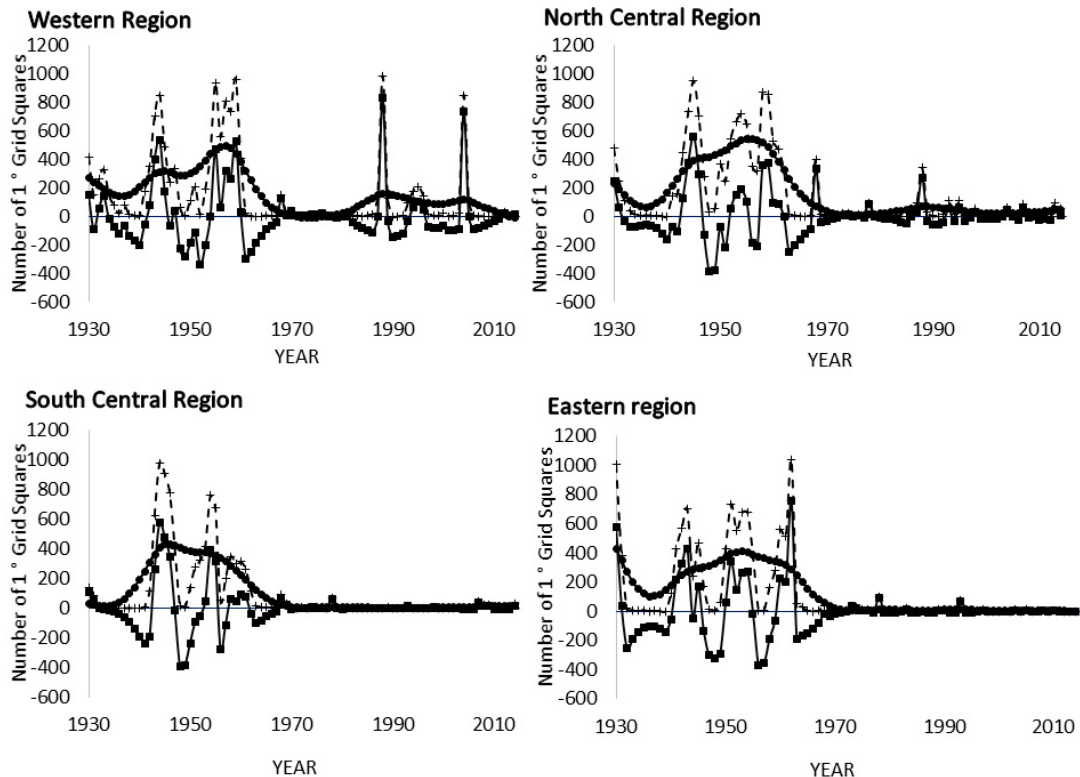
Figure 7. Numbers of 1 ◦ grid squares infested with swarms of Desert Locusts 1930–2014 according to region (crosses), together with results of Kalman filtering to provide low frequency components (circles) and high frequency components (squares).